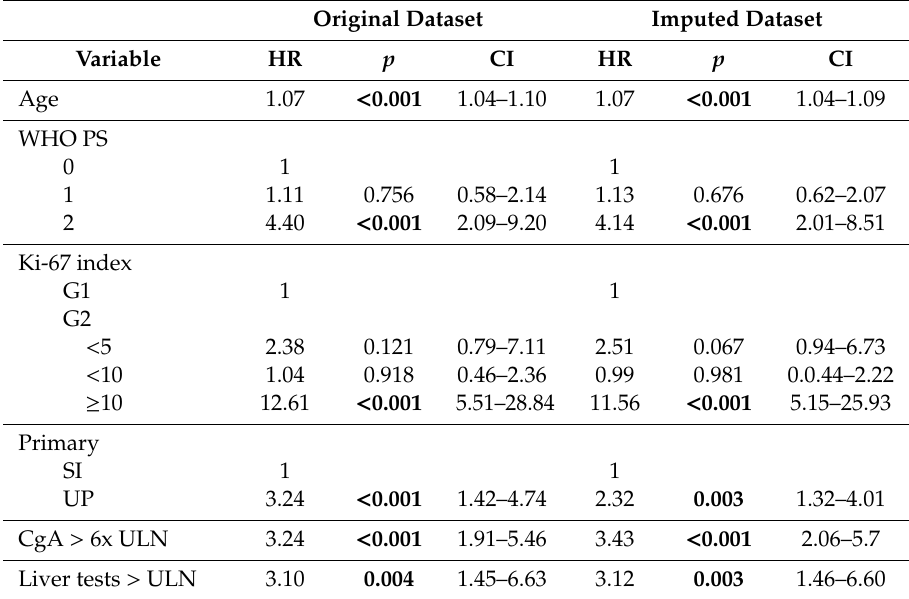
Table 3. Multivariable analysis for disease specific survival in original dataset and imputed